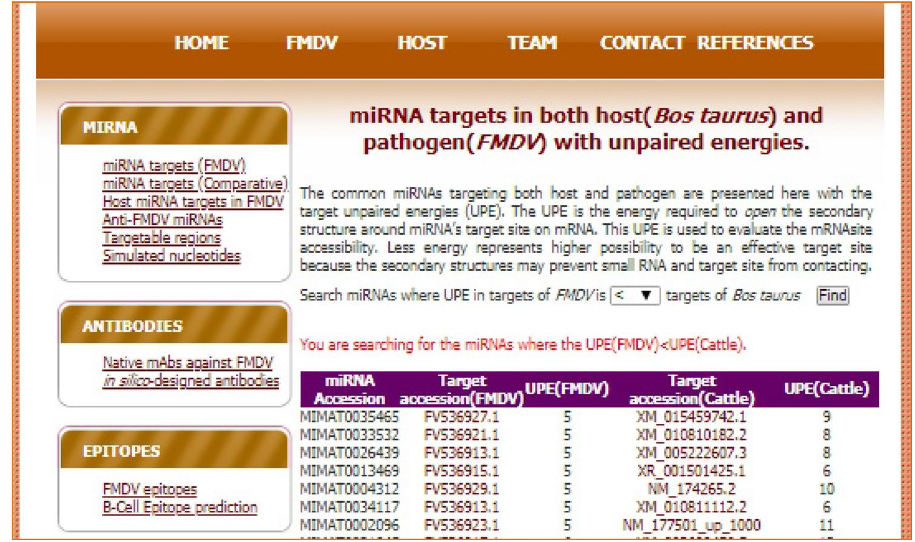
Figure 4. Comparison between FMDV and Bos taurus miRNA targets based on UPE, where a lower UPE represents a better target accessibility.